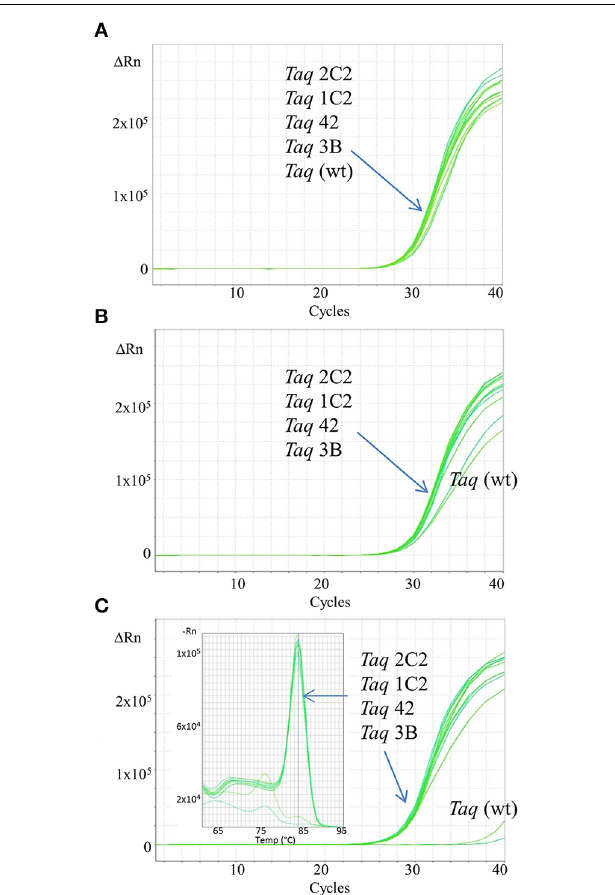
FIGURE 2 | Fast qPCR assays employing SYBR Green. Genomic DNA targets were amplified as described in Methods using 0.5ng human gDNA and 10ng of purified wild-type or mutant Taq DNA polymerase. Reactions were cycled on the StepOnePlus instrument (Life Technologies) using cycling conditions consisting of 3min at 95 ◦ C followed by 40 cycles of 3s at 95 ◦ C, 10s at 60 ◦ C. Genomic DNA targets are as follows: (A) 91bp ABC, (B) 109bp COMTE2, (C) 305bp Numb. Sixty second extension time is required for Taq wild-type to efficiently amplify the 305bp target (data not shown).